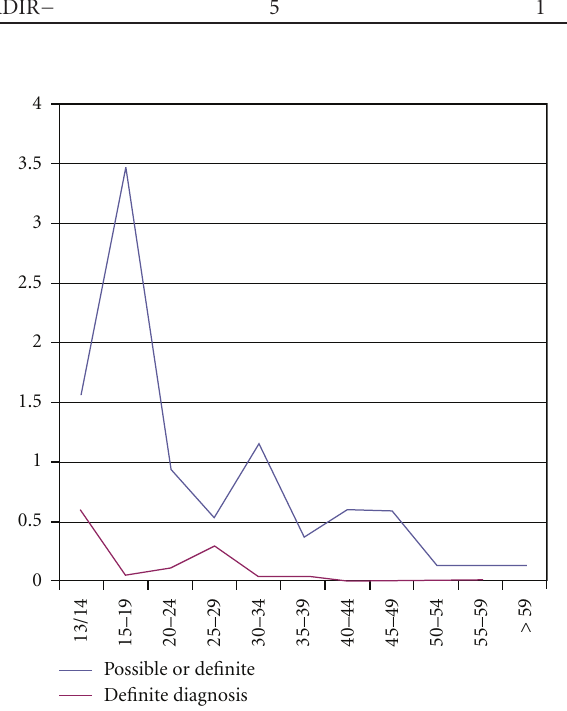
Figure 1: Age-related prevalence of HFPDD in males per 1000 population of the city of She ffi eld in that age